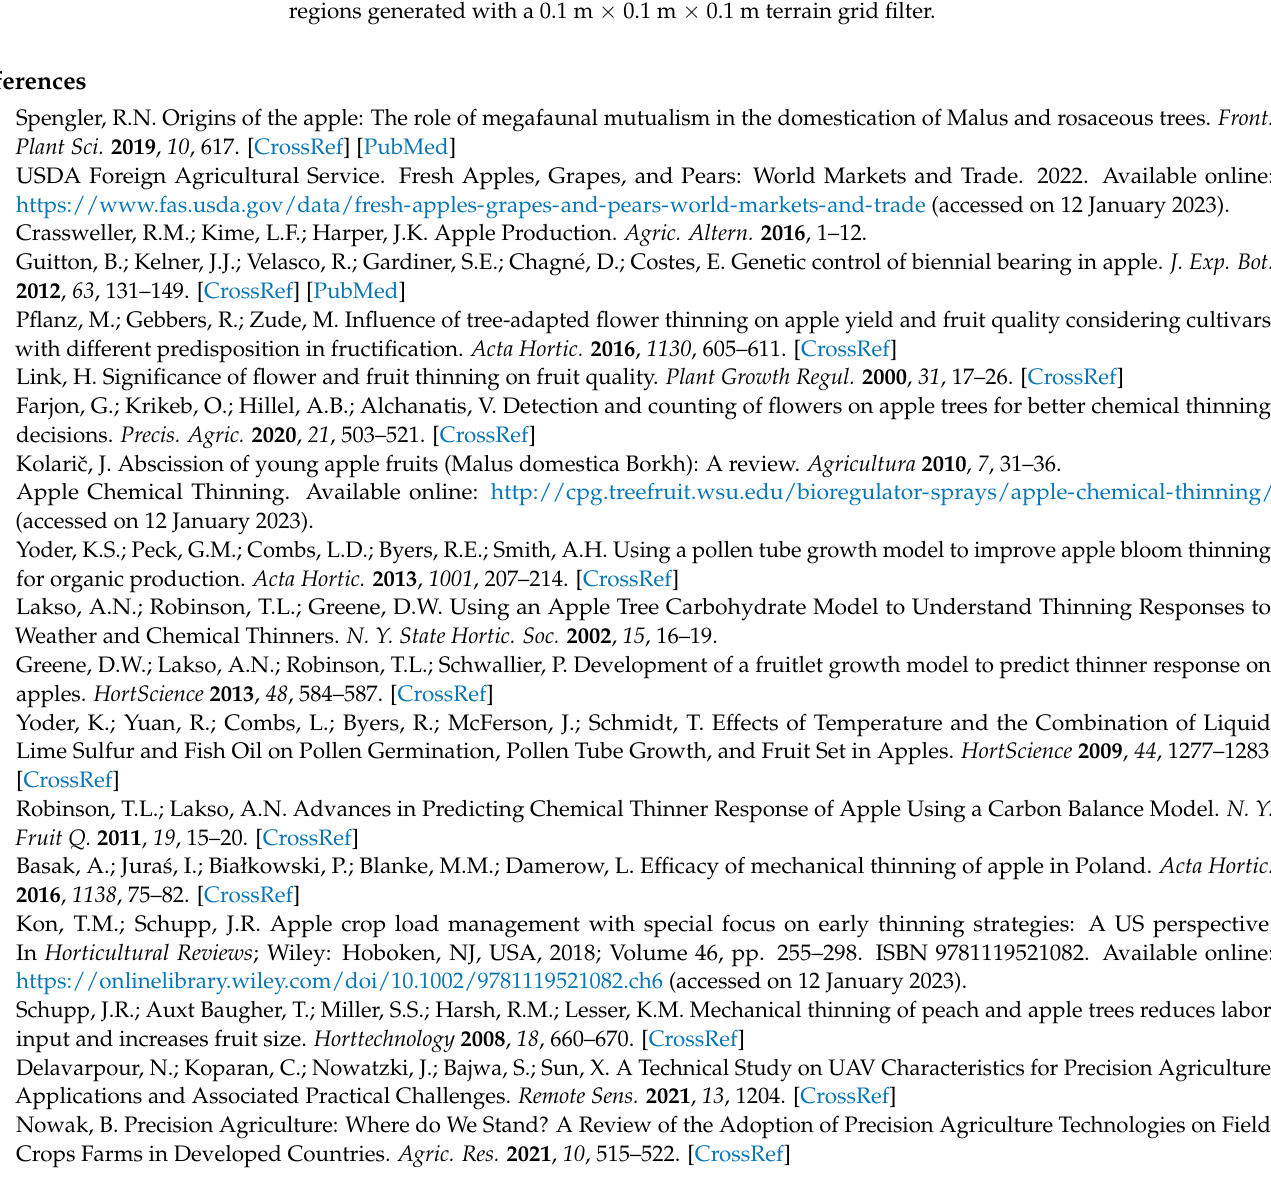
Figure A10. Example blossom density maps of the sample orchard point cloud at different tree height regions generated with a 0.1 m × 0.1 m × 0.1 m terrain grid